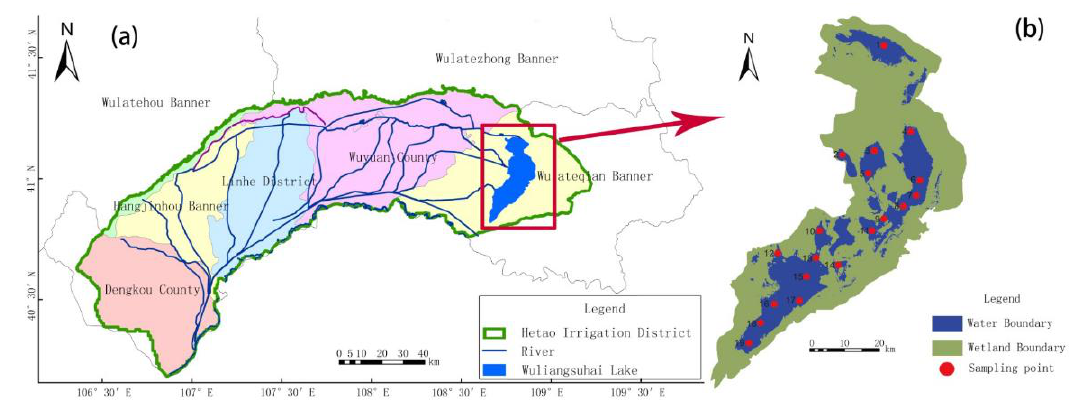
Figure 1. ( a ) The location of Wuliangsuhai Lake. ( b ) The sampling sites in Wuliangsuhai Lake.